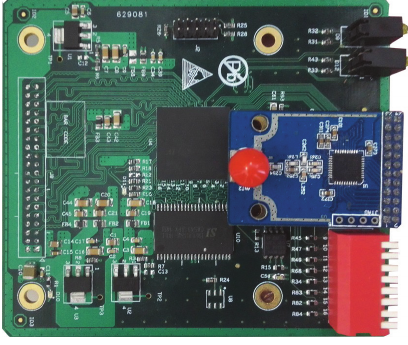
Fig. 10. Integrated WEPL